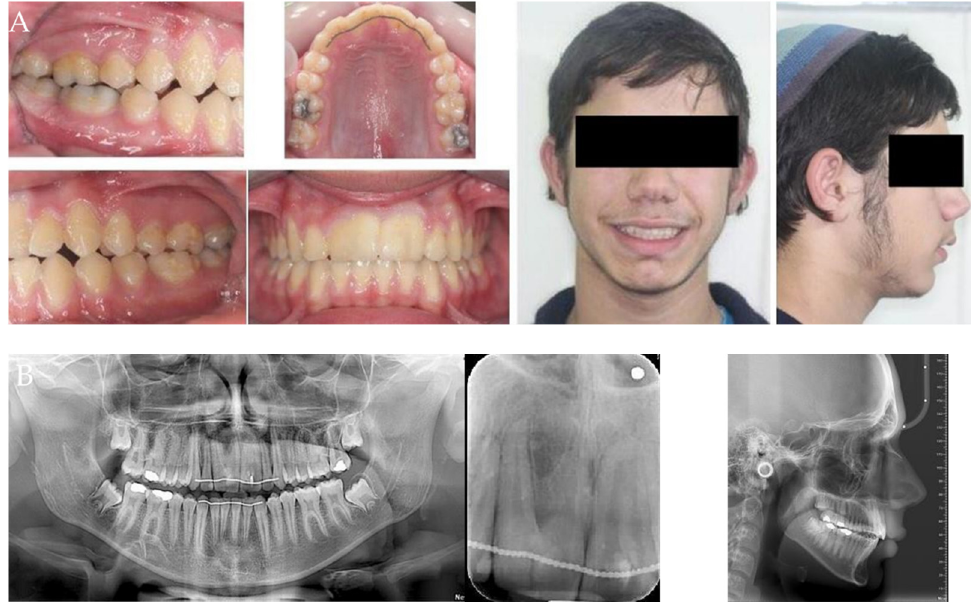
Figure 2. Geminated upper central incisors, a clinical and radiographic view at the end of treatment. ( A ) Intaroral and extraoral view; ( B ) panoramic, periapical, and cephalometric radiographs. (b) Long-term outcomes: the preservation of anterior alveolar bone at an 11 and 15 year post-treatment follow-up is presented, showing stable occlusion and correct occlusal parameters, superb aesthetics, and good periodontal health (Figure 3). No change in dental or skeletal dimensions were noticed. The patients were pleased with the results.